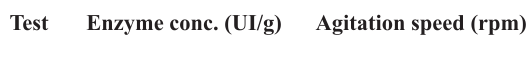
Codified levels and actual values of the variables studied in the enzymatic hydrolysis